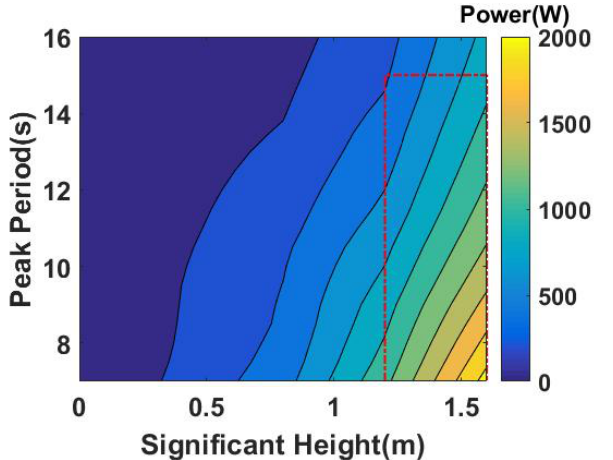
Fig. 14: The CWR of the proposed control with a low control limitation.